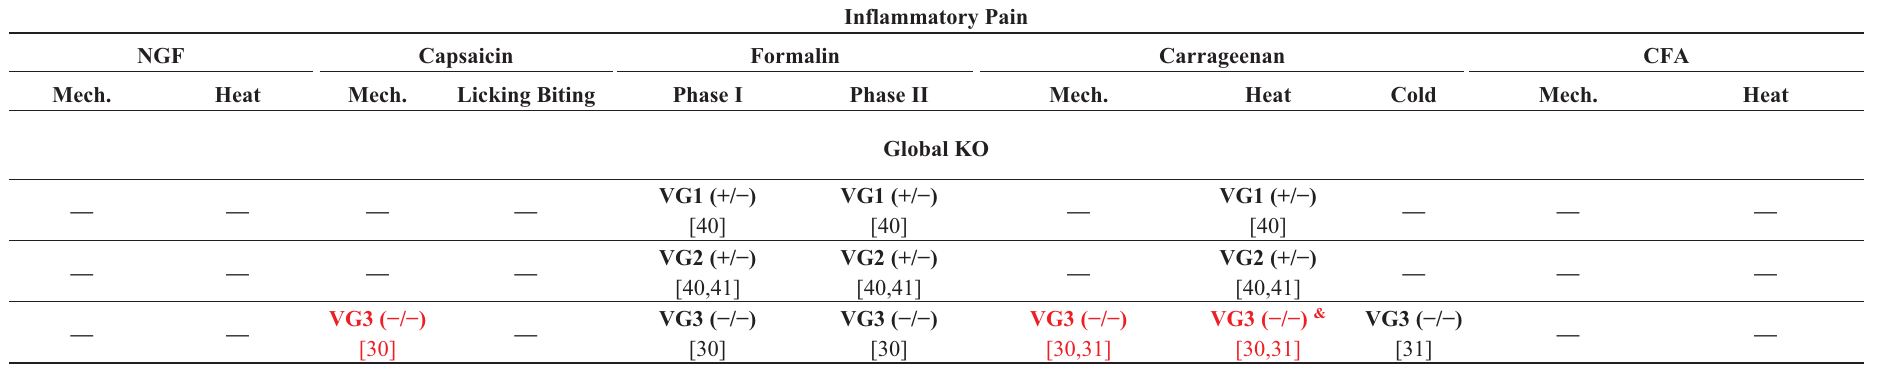
Table 3. Effects on nociceptive pain and itch of various types of VGLUT deletion (Reductions are shown in red, lack of change are shown in black and dashes show pain modalities that have not been assessed; concomitant actions with neuropeptides are shown in purple; & No hyperalgesia according to Draxler et al . 2014 [31]; δ Yes, when concomitant pharmacological blockade of CGRP and/or SP; + Yes, when concomitant pharmacological blockade of SP and CGRP; £ Yes, when concomitant pharmacological blockade of CGRP; * Yes, when concomitant pharmacological blockade of